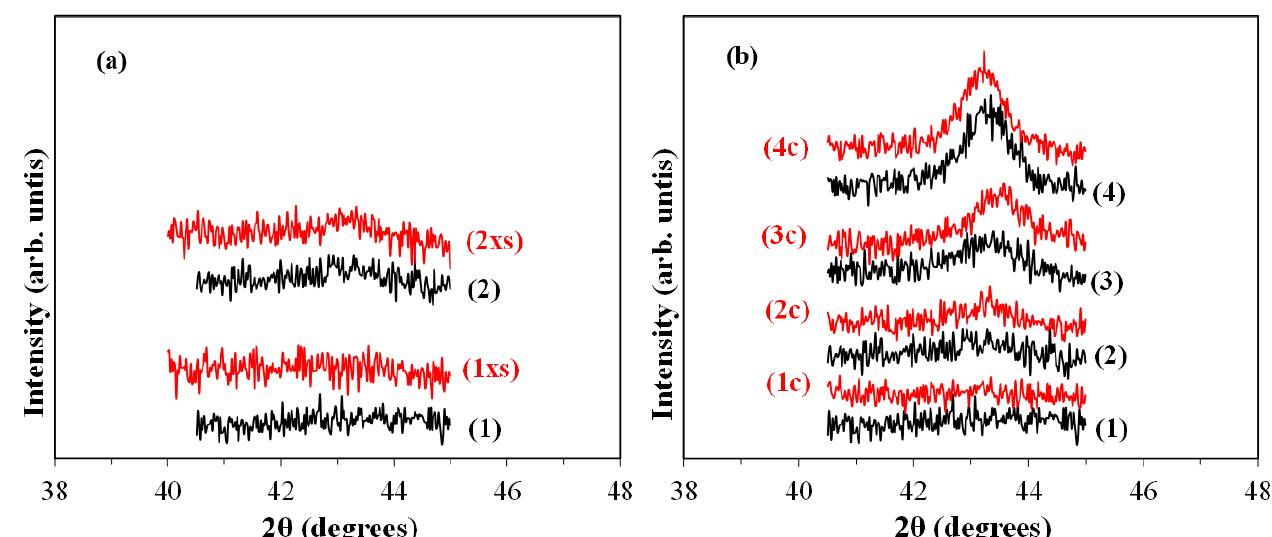
Figure 1. PXRD patterns of SiO 2 -CH-Ni-oc- X samples, prepared via impregnation of SiO 2 with Ni octanoate solution diluted in cyclohexane (see experimental section); X : ( 1 ) 1000 ppm Ni, ( 2 ) 2500 ppm Ni, ( 3 ) 5000 ppm Ni, ( 4 ) 10,000 ppm Ni, ( 5 ) 15,000 ppm Ni, and ( 6 ) 20,000 ppm Ni. The dashed line in the inset graph represents the (2 0 0) reflection of NiO (bunsenite). The pattern of pure NiO (bunsenite structure) is also shown for comparison (blue pattern).